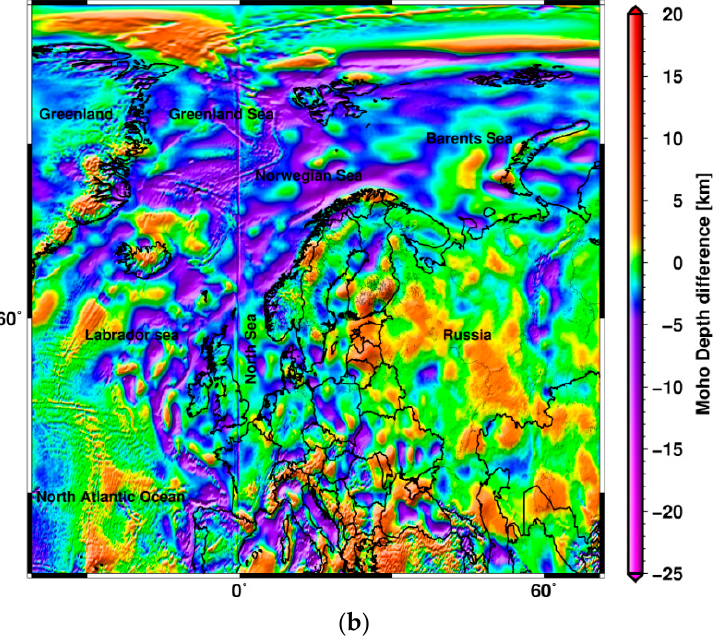
Figure 6. The Moho depth differences between ( a ) the HRCM Butterworth filter solution and the European Plate Moho model [29] and ( b ) the HRCM spectral combination solution and the European Plate Moho model [29]. Unit: km.